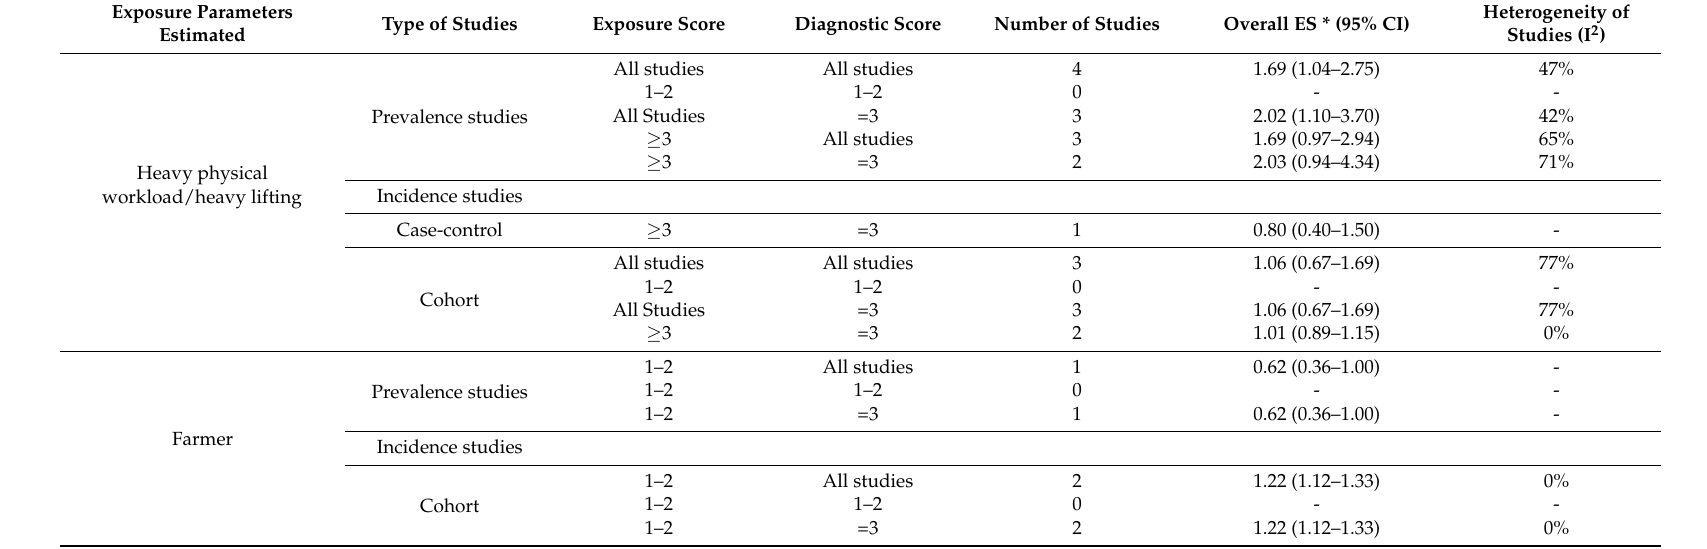
Table 6. Results of meta-analysis depending on the type and quality level of published studies for